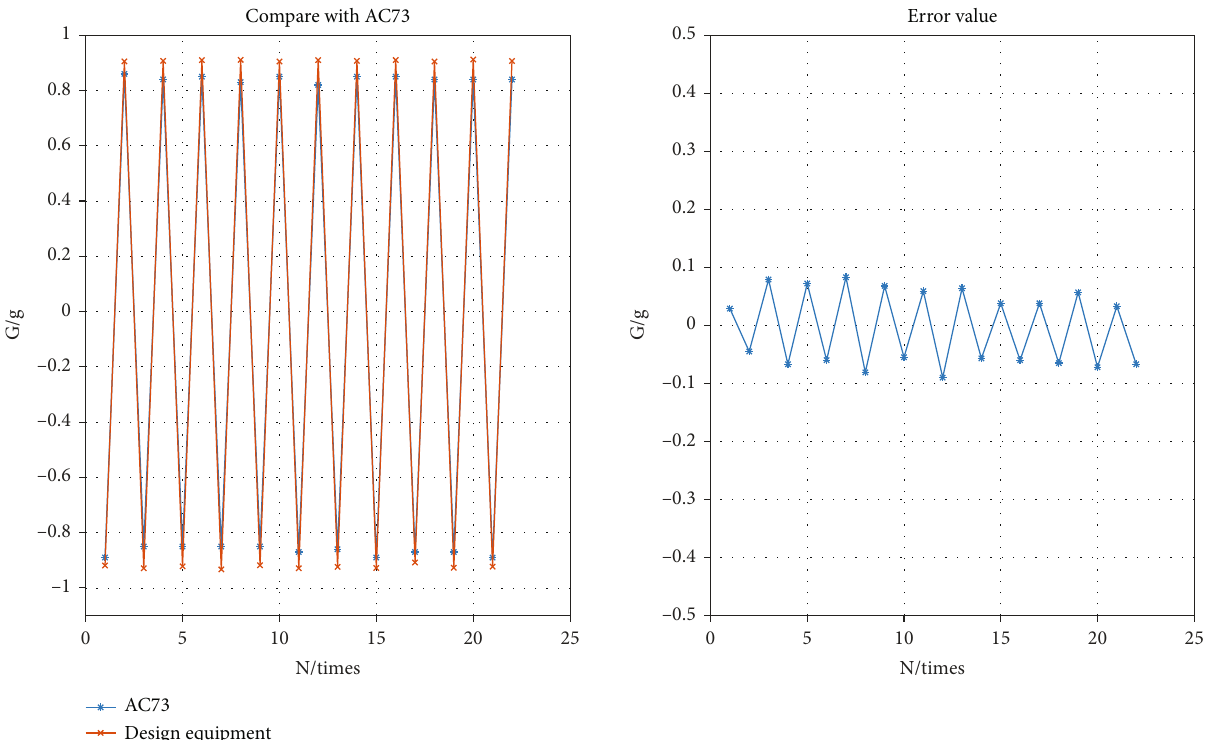
Figure 11: Measurement comparison test of the shock and vibration acceleration recorder and AC73 seismic acceleration sensor (vibration platform test